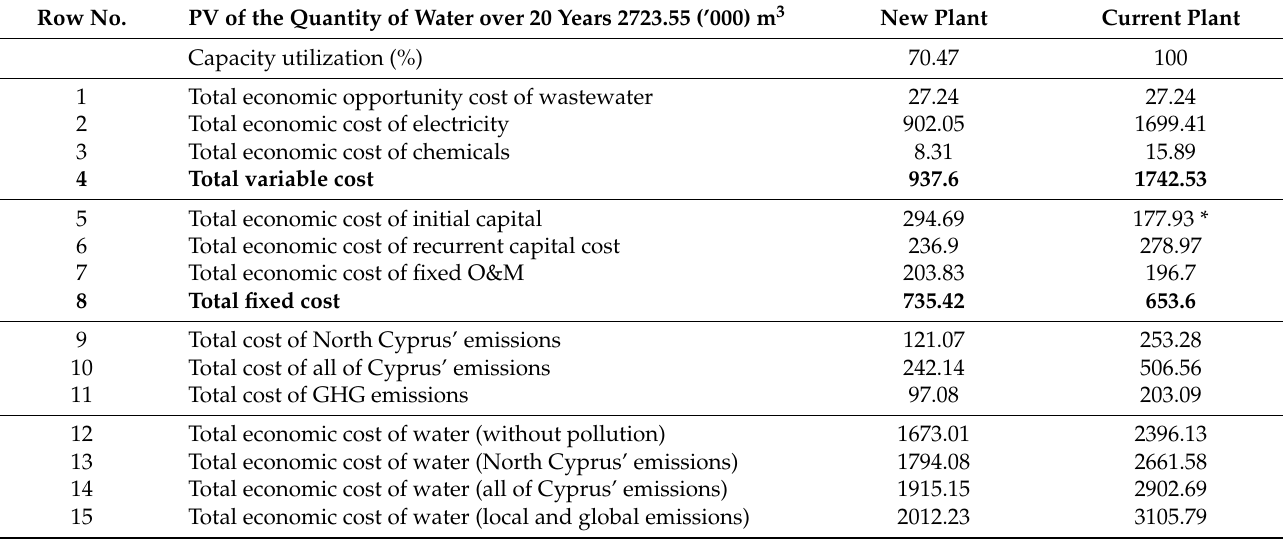
Table 13. Present value at 8% of the total economic costs for different capacity utilization levels with heavy fuel oil emissions, in USD (’000).